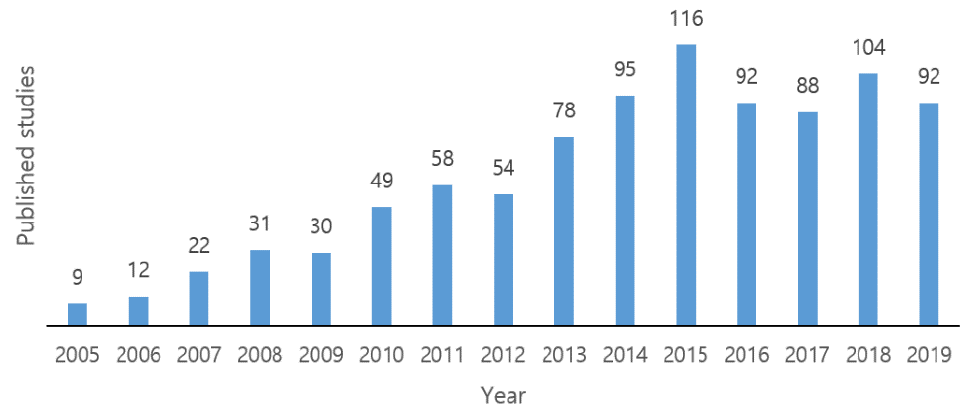
Figure 1. Statistics on the publication related to OR with ADCM in WSNs.